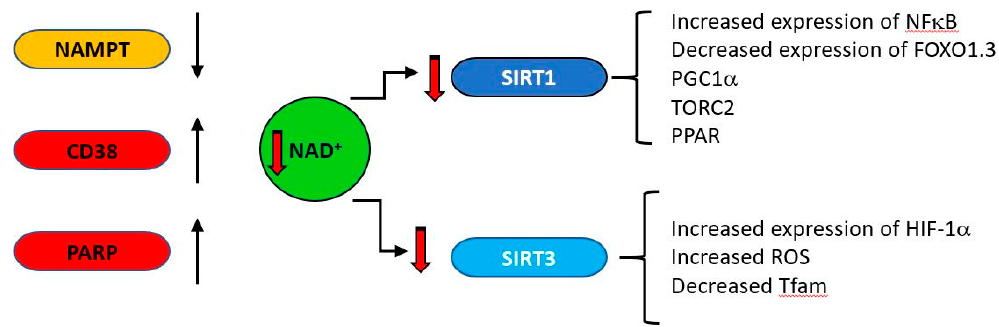
Figure 6. During ageing, upregulation of NAD consuming enzymes such as CD38 and poly (ADP-ribose) polymerase (PARP) and down regulation of the synthetic enzyme nicotinamide phosphor-ribosyltransferase (NAMPT) result in reduced levels of NAD. This is results in lower activity of the NAD–dependent deacylases (sirtuins). SIRT1 and SIRT3 regulate a variety of mitochondrially related functions whose age related change is regarded as deleterious, including decreases in transcription of genes such as PGC1a, PPAR, TFAM and FOXO1.3 and upregulation of NF κ B.